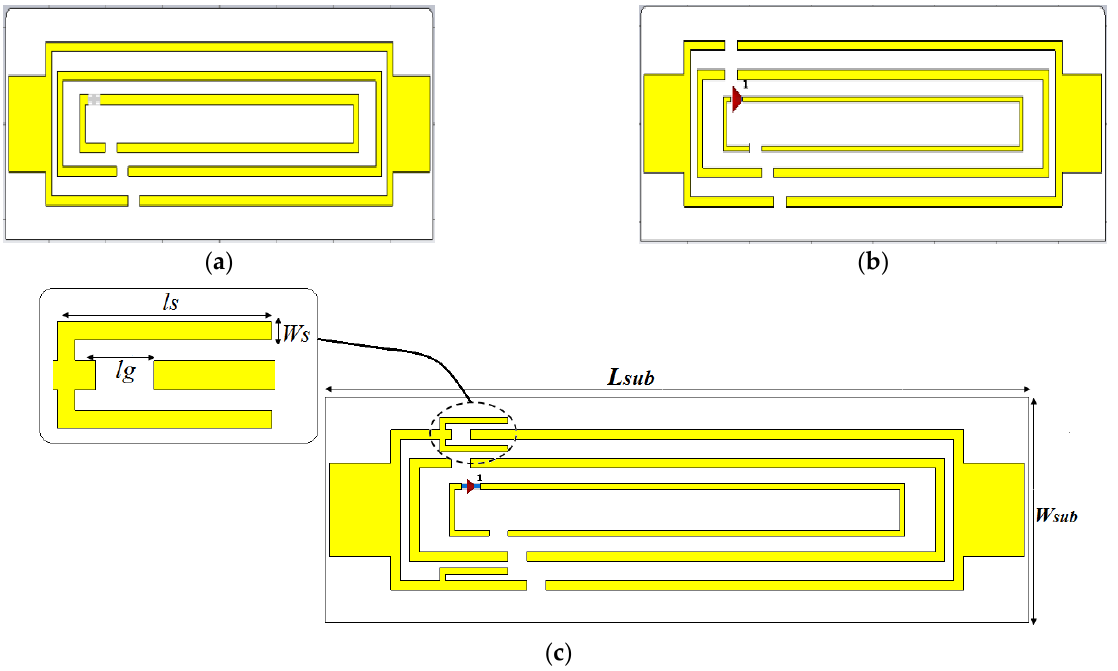
Figure 5. Proposed structure: ( a ) without gaps and stubs; ( b ) with gaps; ( c ) with gaps and stubs.